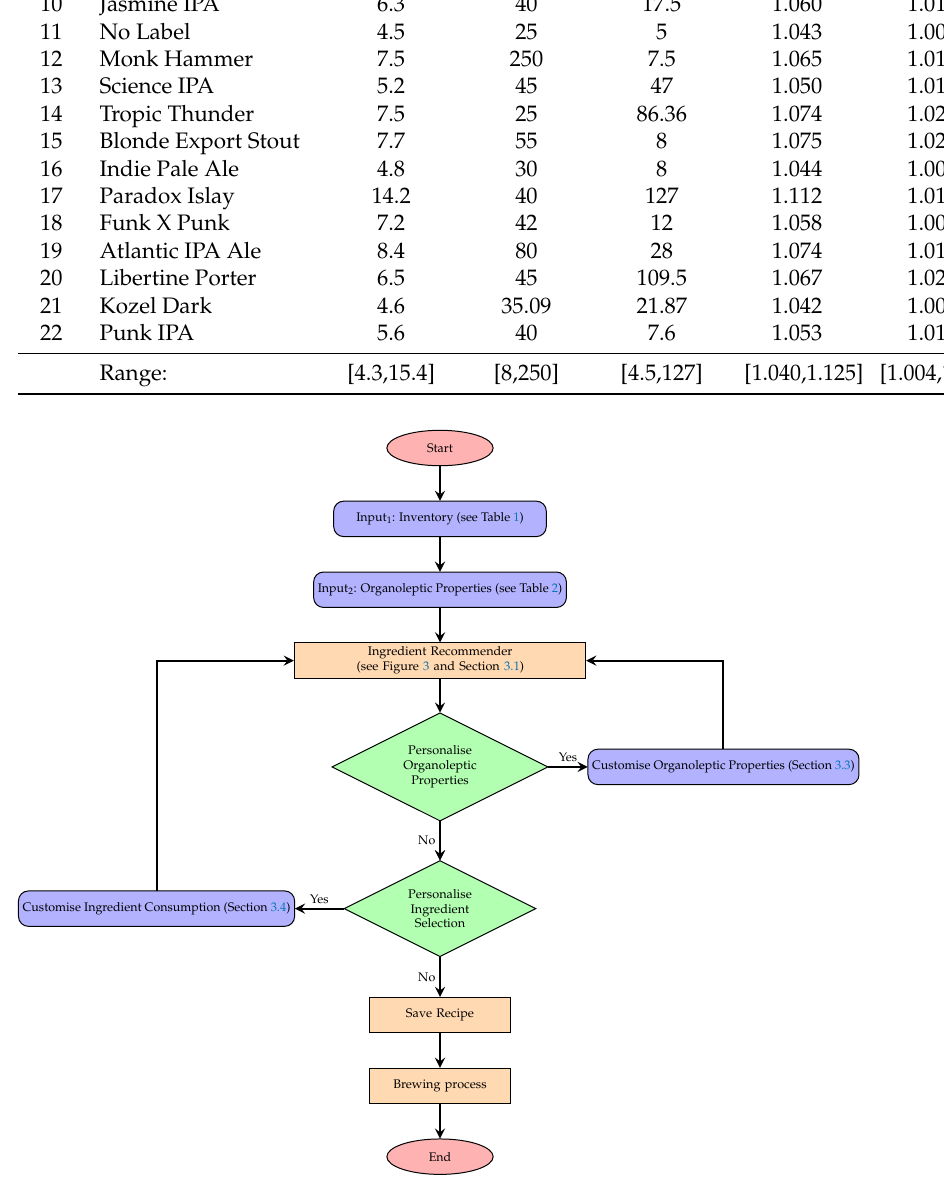
Figure 2. System architecture (please see Tables 1 and 2, Figure 3, Section 3.1, 3.3 and